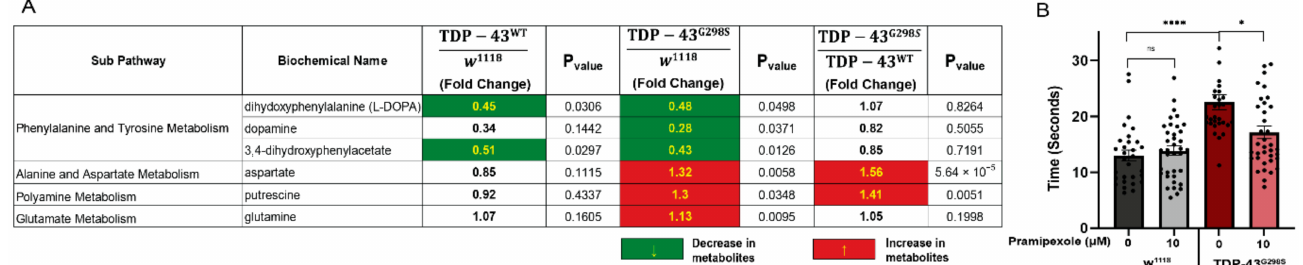
Figure 4. TDP-43 proteinopathy induces alterations in neurotransmitters and their precursors. ( A ) Summary of significantly altered neurotransmitters, their metabolites, and precursors in TDP WT and TDP G298S compared to w 1118 controls. Red indicates significant upregulation and green indi- cates significant downregulation. Statistical significance was determined using one-way ANOVA. ( B ) Larval turning assays for Drosophila expressing TDP-43 G298S fed a cornmeal-based media sup- plemented with 10 µ M pramipexole, as indicated on the x -axis. DMSO was used as vehicle. n = 30 larvae per treatment/per genotype. Kruskal–Wallis test was used to determine statistical